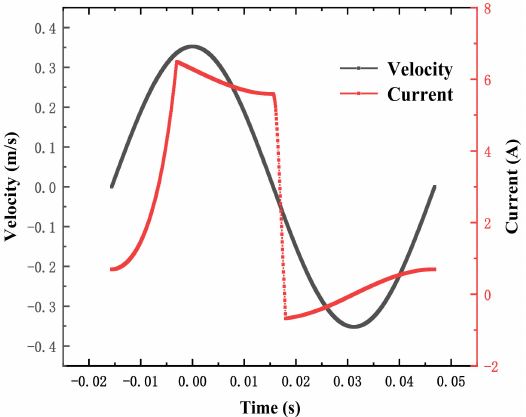
Figure 5. The calculated current and speed curves of the SVLC.